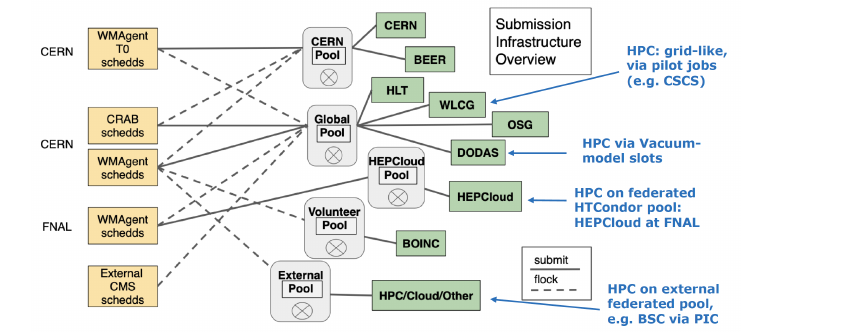
Figure 2. Schema of the CMS SI, modified from [25], indicating the mechanisms that allow the al- location and exploitation of resources at HPC sites. On the left-hand side, a number of redundant and geographically distributed WM submission nodes (HTCondor schedds ) manage the diverse CMS work- load types. These nodes, can be assigned resources from a number of HTCondor resource pools, each managed by a central node running collector and ne g otiator services that produce the matchmaking to resources belonging to the same pool, or by allowing overflow of workload to a neighboring federated pool ( flockin g ). Diverse CPU resources, summarized on the right-hand side of the diagram, include WLCG and CERN job execution slots, but also opportunistic o ffl ine usage of the CMS HLT farm, among others. The integration of HPC resources into this flexible infrastructure can be achieved by a number of technical ways, as described in section 2.4